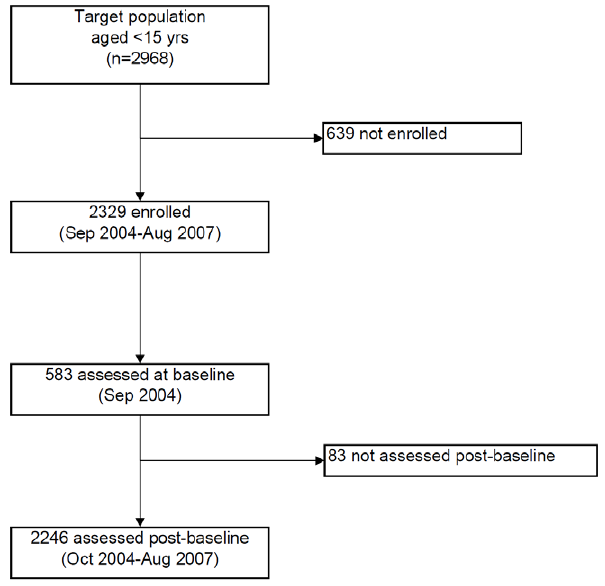
Figure 1. Participation in EAHSP, September 2004–August